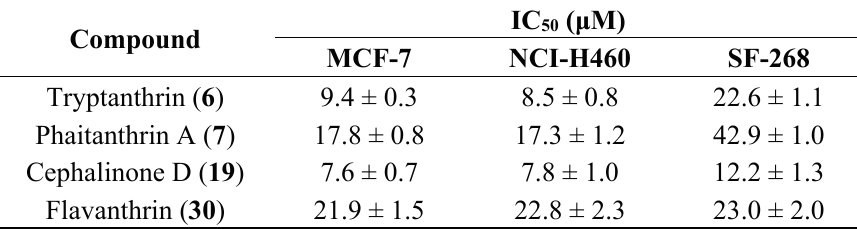
Table 3. Cytotoxicity of active compounds toward three cancer